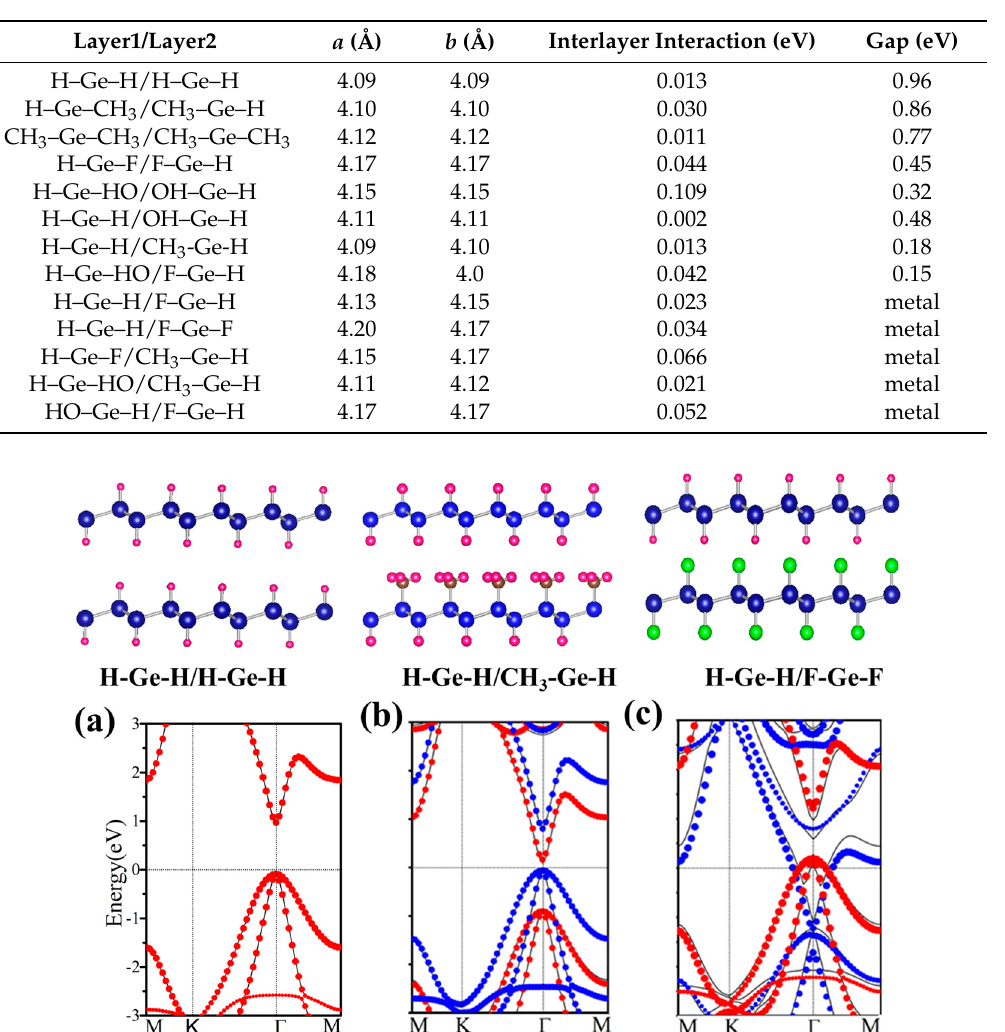
Figure 9. Relaxed geometry structures of H–Ge–H/H–Ge–H, H–Ge–H/CH 3 –Ge–H and H–Ge–H/F–Ge–F and the corresponding energy spectra ( a – c ). The black line is the energy dispersion of the bilayer. The red (blue) dots represent the spectra of the isolated up (below) layer. In panel ( a ) red dots coincide with the blue dots.